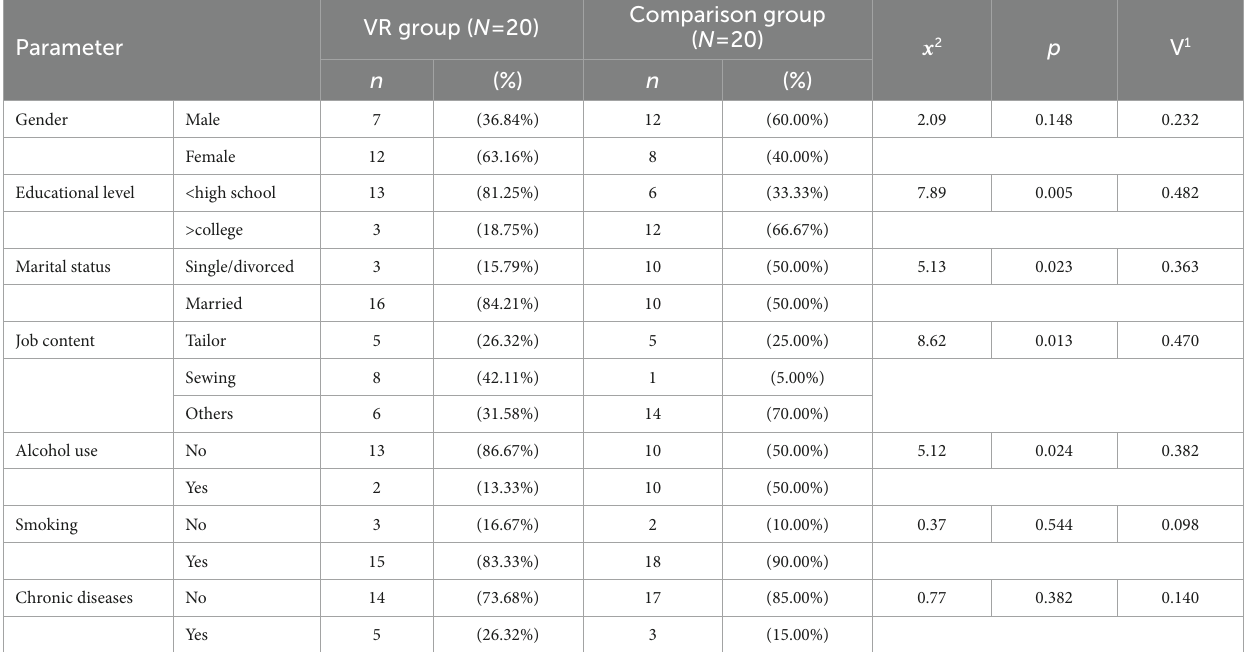
TABLE 1 Participants’ backgrounds.